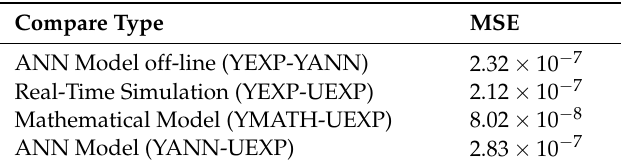
Table 3. MSE ball position comparison among